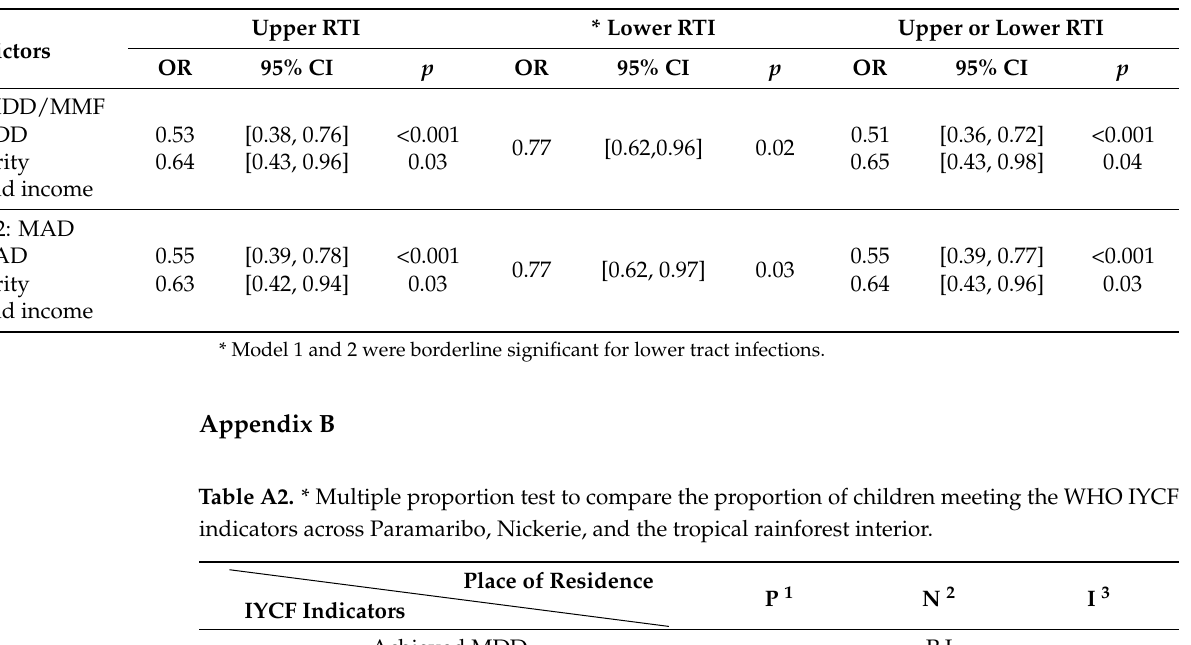
Table A1. Predictors of (upper and lower) respiratory tract infections.